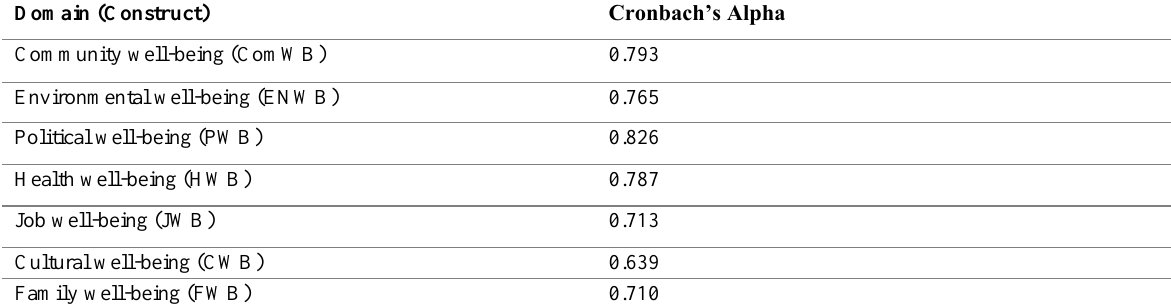
Table 1: Cronbach’s alpha for All Well-Being